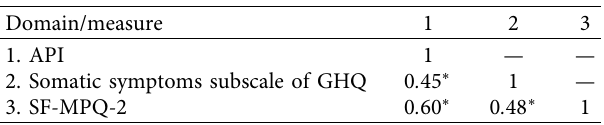
Table 4: Correlation coefficients of API with the somatic symptoms of GHQ and SF-MPQ-2.